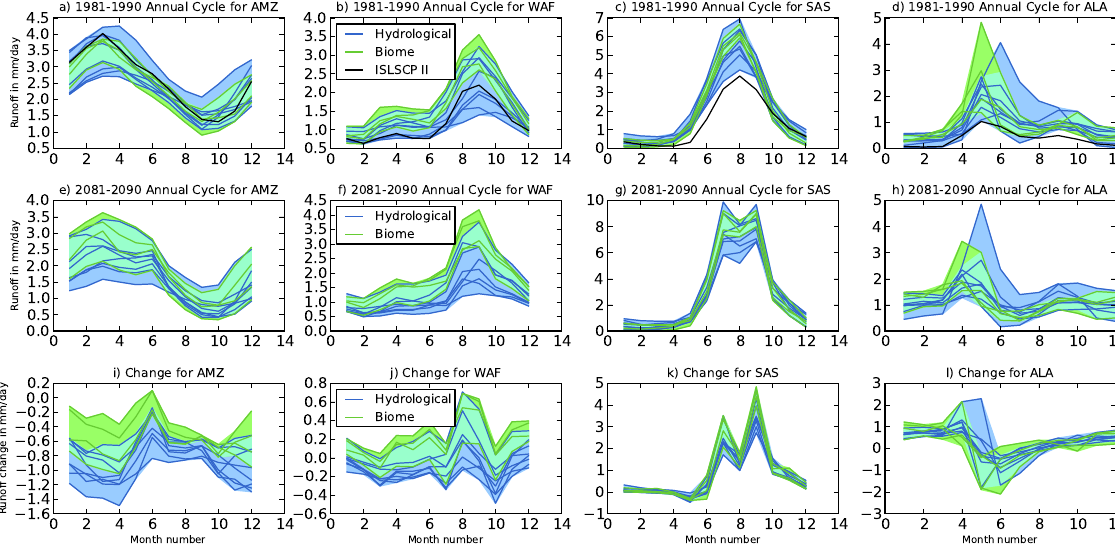
Fig. 4. Annual cycles of runoff for selected Giorgi regions using ISI-MIP (Warszawski et al., 2013) model runs forced with HadGEM2-ES RCP8.5 climate. (a–d) : absolute values for 1981–1990, (e–h) : absolute values for 2081–2090, (i–l) : absolute changes between 1981–1990 and 2081–2090.